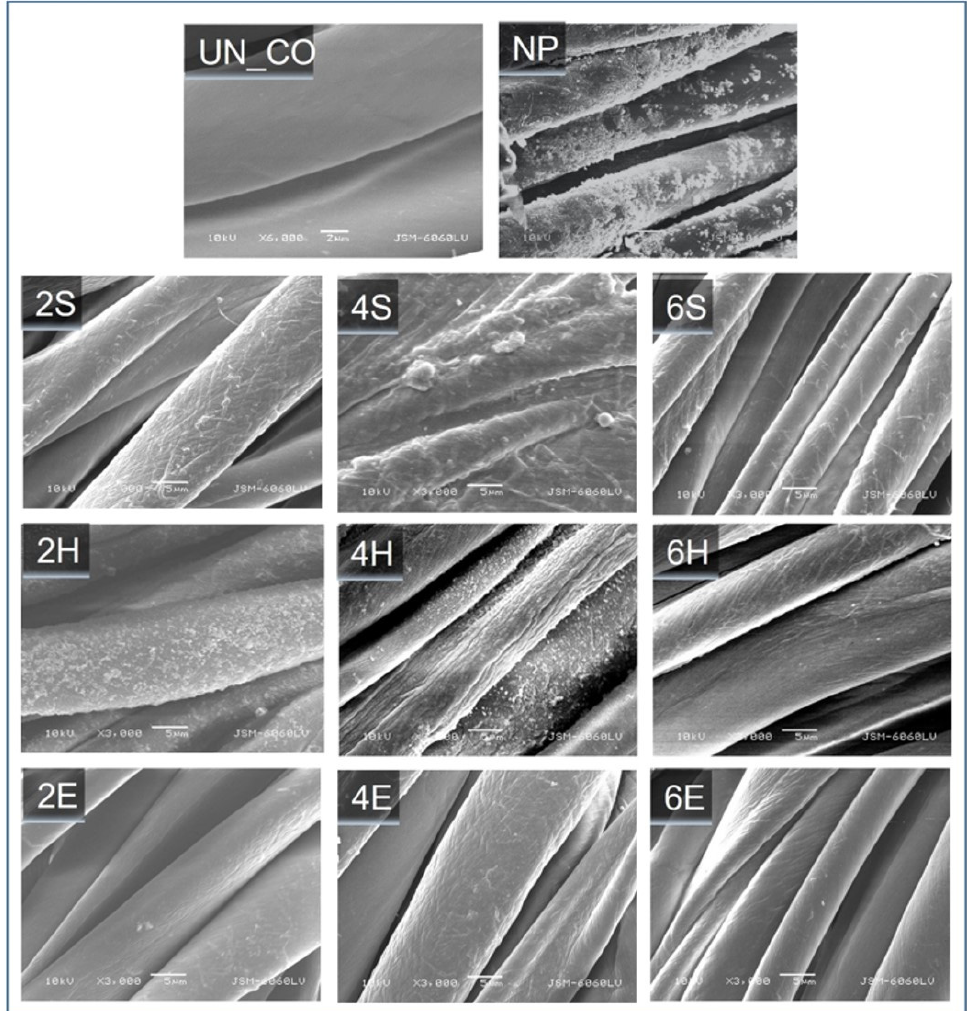
Figure 1. SEM images of the untreated cotton sample (UN_CO), the sample treated with a commercial TiO 2 product (NP), and samples treated via in-situ synthesis routes, i.e., sol–gel pad–dry–cure (xS), pad–hydrothermal (xH), and exhaustion hydrothermal (xE), using different concentrations of titanium isopropoxide (x = 2, 4, and 6%) in the nanosol.